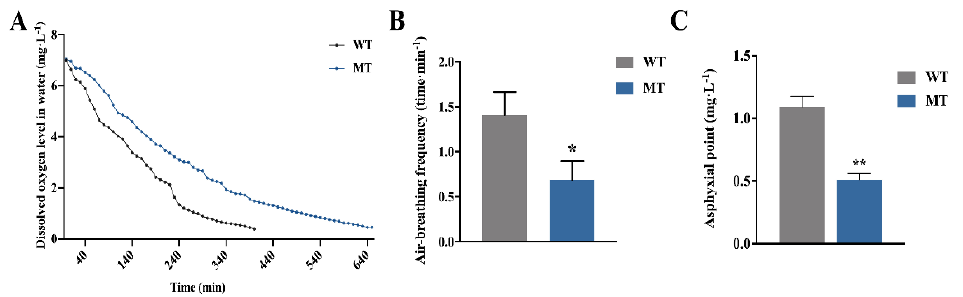
Figure 8. The effects of fn1b -depletion on air-breathing function of WT and MT loach under chronic hypoxia. ( A ) Water dissolved oxygen levels in the sealed conical flasks with WT and MT loach. ( B,C ) Comparison of air-breathing frequency ( B ) and asphyxia point ( C ) between WT and MT loach under chronic hypoxia. WT, wild-type loach; MT, fn1b -depletion loach. * significant difference ( p < 0.05); ** very significant difference ( p < 0.01).